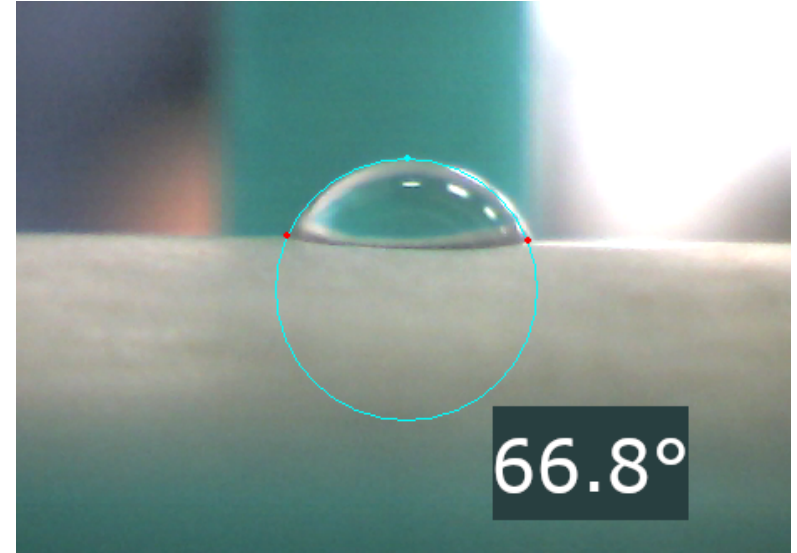
Figure 8. Smooth IN surface contact